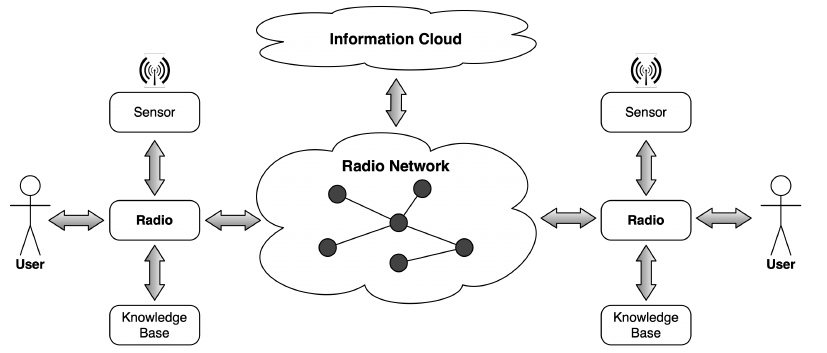
Figure 1. A cognitive radio in